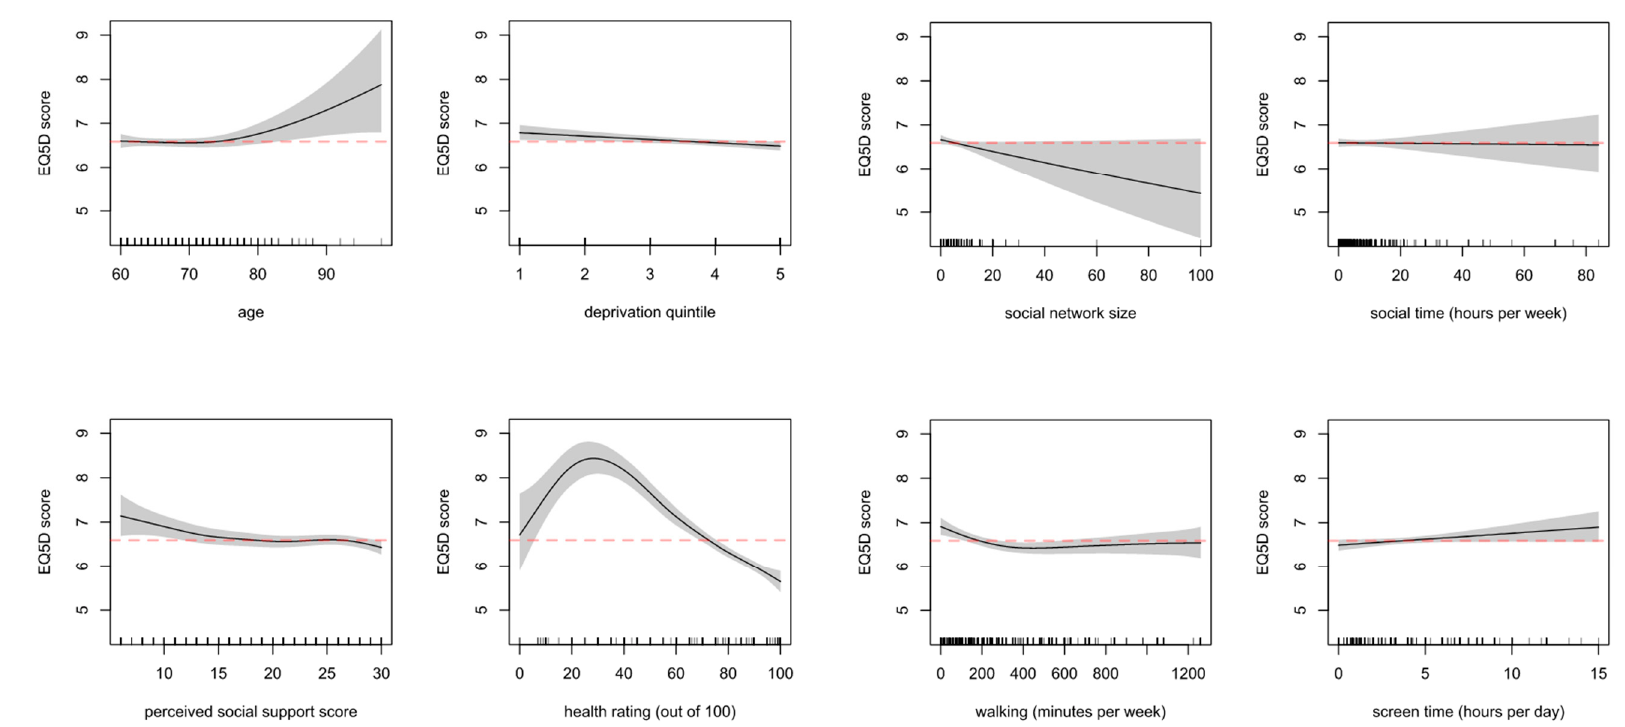
Figure 4. Associations with wellbeing (EQ5D-3L) for continuous and ordinal variables on the outcome scale, from top left to bottom right: age, deprivation quintile, social network size, social time. From bottom left to bottom right: perceived social support (BPSSQ score), health rating, self-reported walking, and screen timeThe dashed line indicates the model intercept (the model average when all other covariates are kept at their average/reference level).